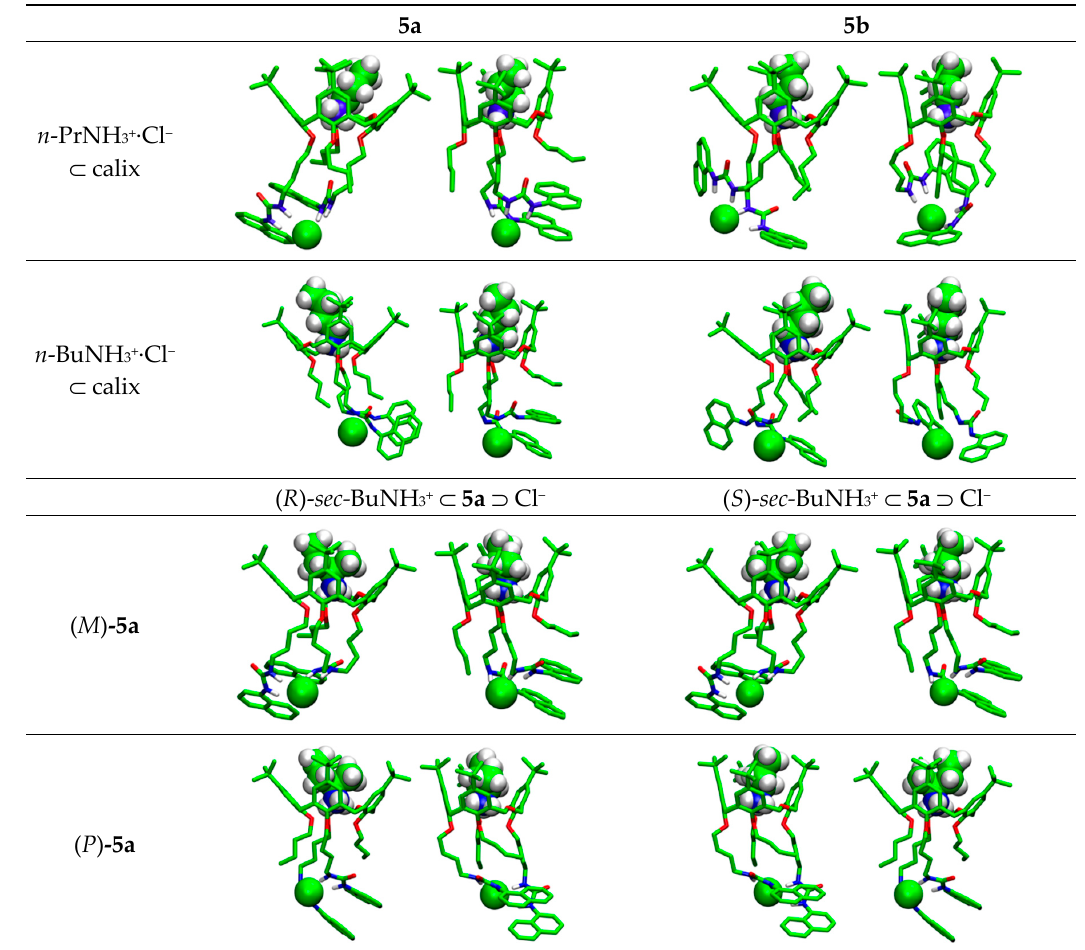
Figure 10. Structures of the R-NH 3 + ⊂ calix ⊃ Cl − complexes after QM optimization (orthogonal views). The atomic species are represented in CPK colours, except carbons that are in green.